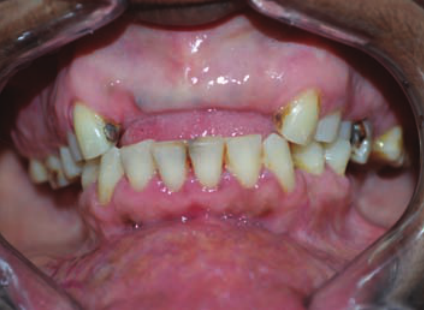
Figure 9: Clinical picture of 62-year-old mother with missing teeth.